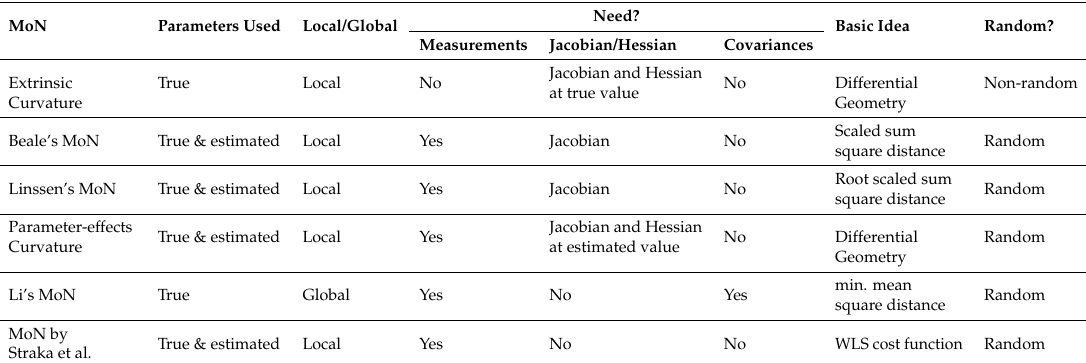
Table 1. Features of Various